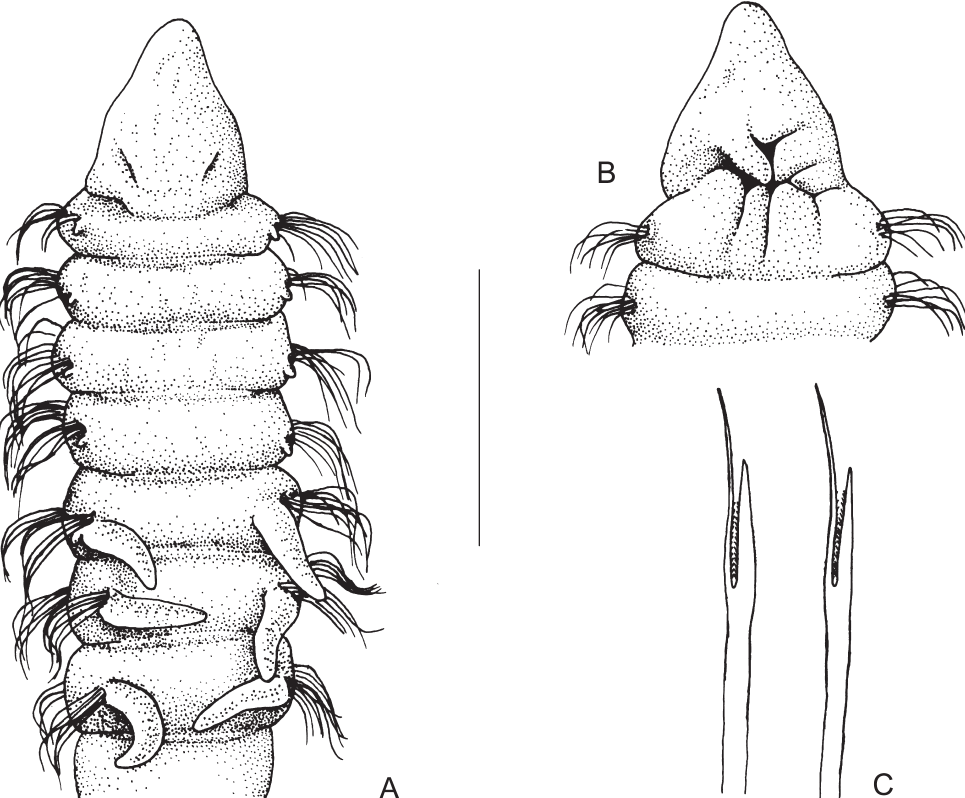
Fig . 10. – Paradoneis bathyilvana n. sp.: A, anterior region, dorsal view; b, anterior region, ventral view; c, lyriform dorsal modified chaetae, chaetigers 14 and 24. Scale bar: A 260 µ m; b 225 µ m; c 40 µ